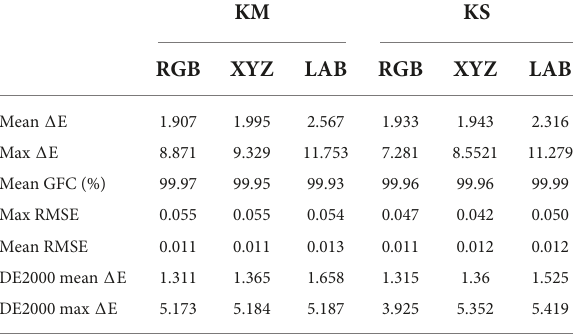
TABLE 3 Spectral recovery results in different weighted color